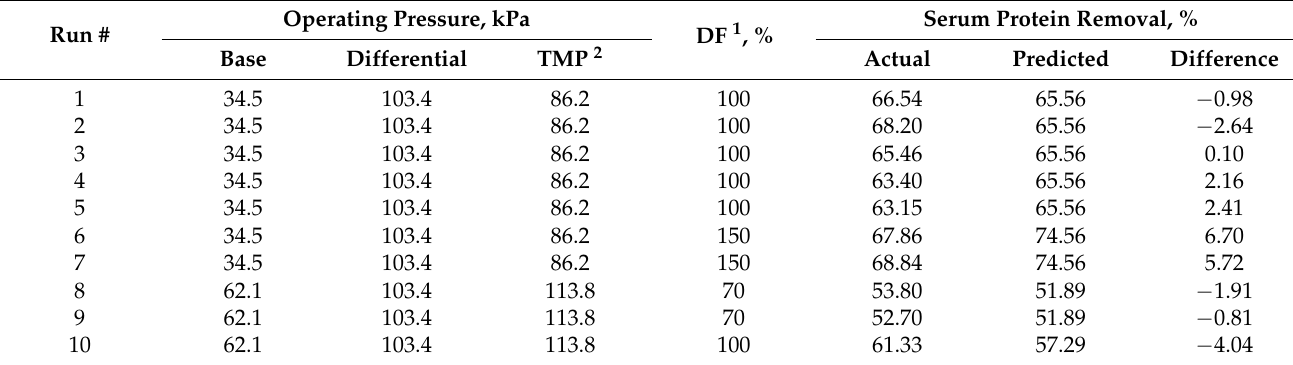
Table 2. Comparison of SP removal predicted by the model and actual SP removal data obtained from the experiments.